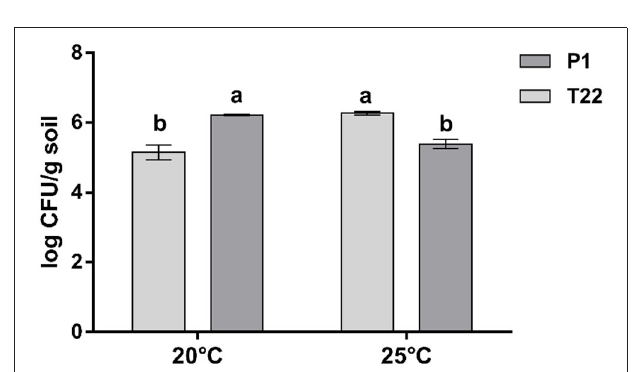
FIGURE 2 | Trichoderma colonies in soil. Effect of temperature (20 and 25 ◦ C) on the number (means ± SD) of fungal colony-forming units (CFU) in soil samples obtained from the rhizosphere of tomato plants inoculated with Trichoderma strain T22 or P1, 5 days after inoculation on Trichoderma selective media (TSM). Values are the means of three replicates; bars with different letters indicate significant differences according to Fisher’s test at P ≤